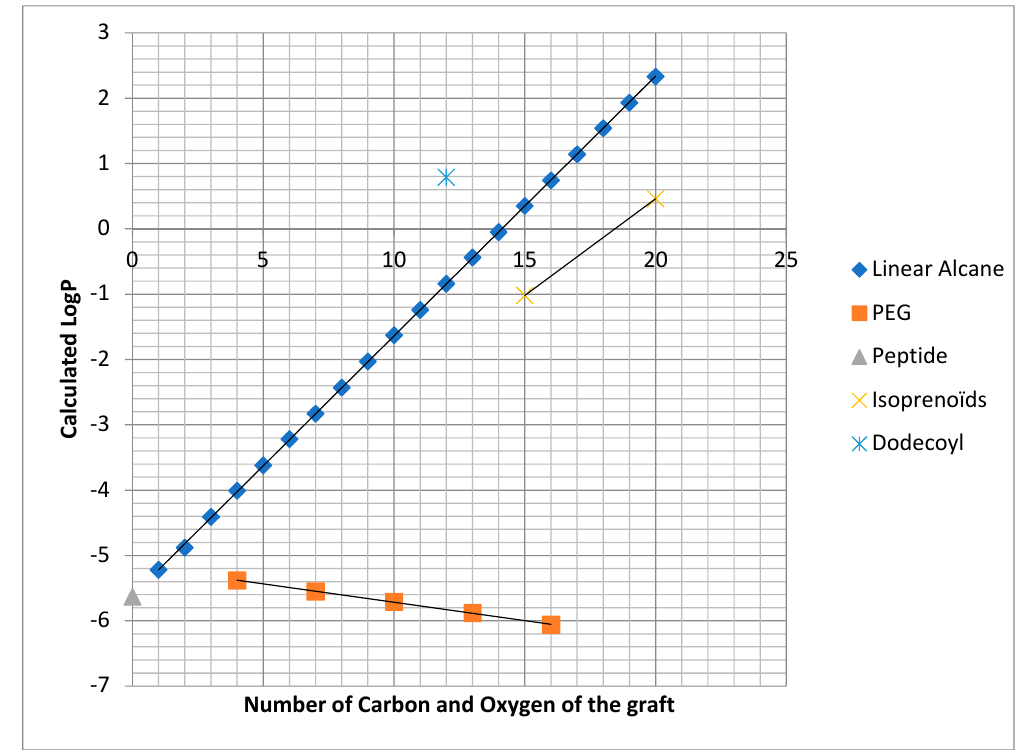
Figure 1. c LogP of L ‐ PDC31 analogs relative to the number of heavy atoms present in their grafts.